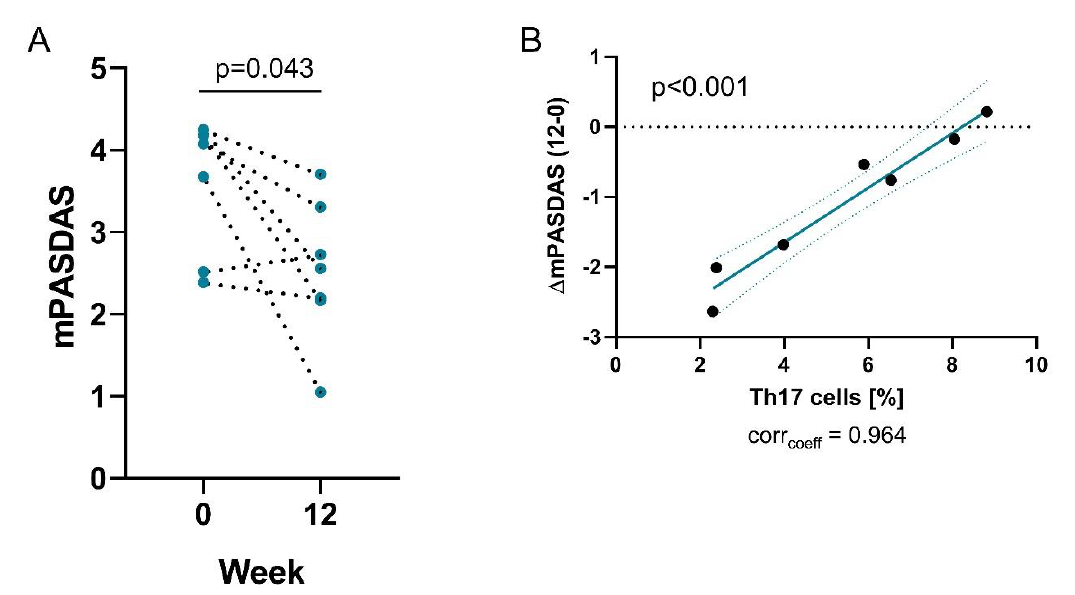
Figure 1. Probiotics treatment decreases disease activity. Graphs show ( A ) mPASDAS score at baseline (0) and week 12 of treatment with probiotics; ( B ) Correlation of the change of PASDAS from baseline to week 12 with the frequencies of Th17 cells (right).